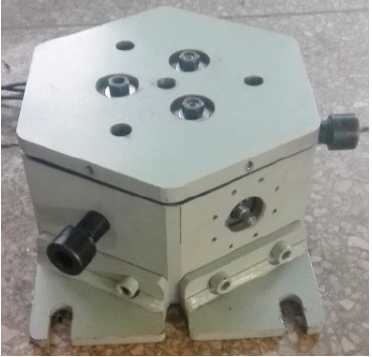
Figure 15. Prototype of the parallel three-dimensional force sensor.